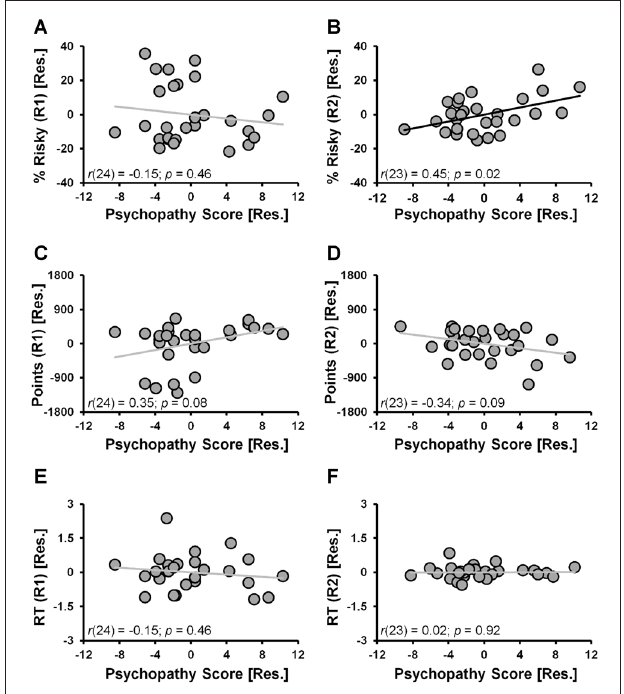
FIGURE 2 | CDMT behavioral outcomes as a function of psychopathy scores. (A,B) Trait psychopathy scores were differentially correlated with the percent of risky selections (% Risky) made in Run 1 (A) vs. Run 2 (B) (RUN × PSYCHOPATHY: p = 0.024). Whereas during Run 1 the correlation failed to reach significance ( p = 0.46), during Run2, risky selections were positively correlated with psychopathy scores ( p = 0.02). (C,D) Trait psychopathy scores were differentially correlated with the total number of points accumulated in the two task runs (RUN × PSYCHOPATHY: p = 0.016). Although failing to reach significance, during Run 1 there was a positive relation between points accumulated and psychopathy ( p = 0.08), whereas during Run 2 this correlation was negative ( p = 0.09). (E,F) Trait psychopathy scores were not related to reaction times (RTs) from either Run 1 (E) or Run 2 (F) of the task. To facilitate visual interpretation of the partial correlations, the scatter plots depict residualized values for the variables shown on the x- and y-axes (indicated by [Res.]) where the influences of the controlled variables have been removed (scatter plots of the raw values can be found in Supplementary Figure S2). Black best fitting lines indicate a statistically significant partial correlation and gray lines indicate associations that failed to reach